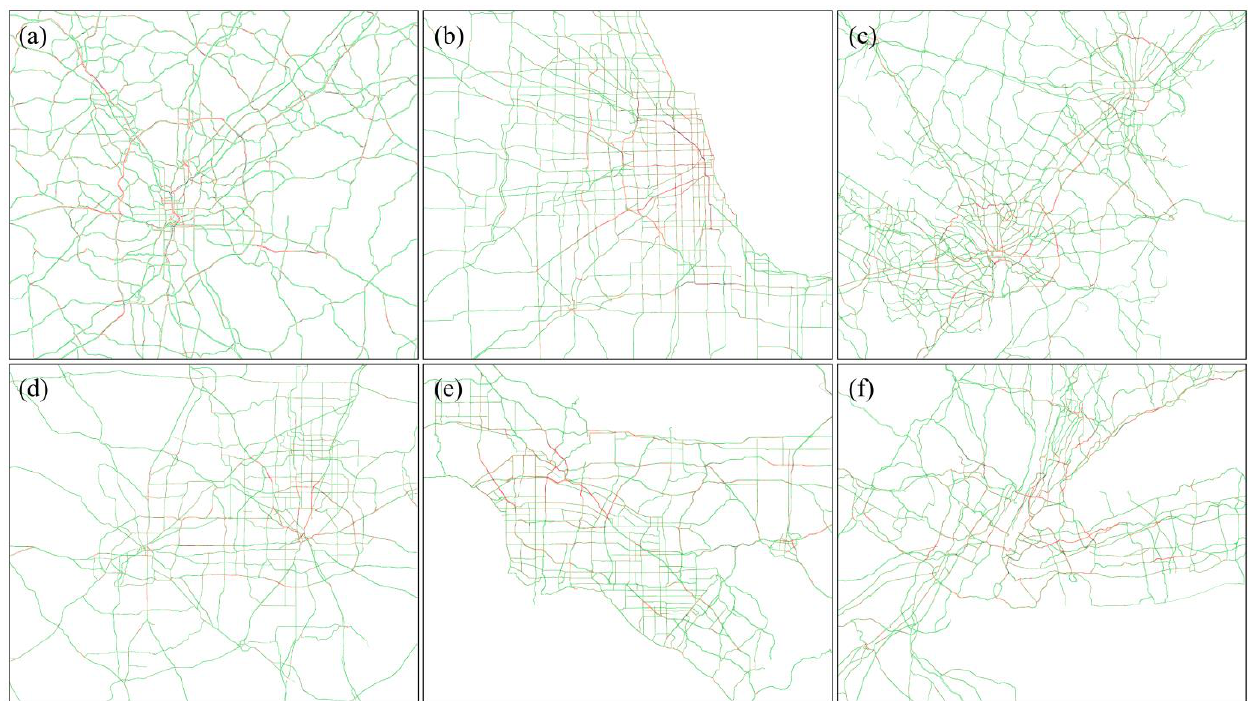
Figure 2. Case study areas and sample snapshot images. The images show the extent of six study areas and their traffic intensity levels identified with the Google Traffic Layer API at 5:00 p.m. (local time) on Friday, 22 April 2022. The map scales are not the same. ( a ) Atlanta, GA; ( b ) Chicago, IL; ( c ) Washington, D.C. and Baltimore, MD; ( d ) Dallas and Fort Worth, TX; ( e ) Los Angeles, CA; ( f ) New York, NY.